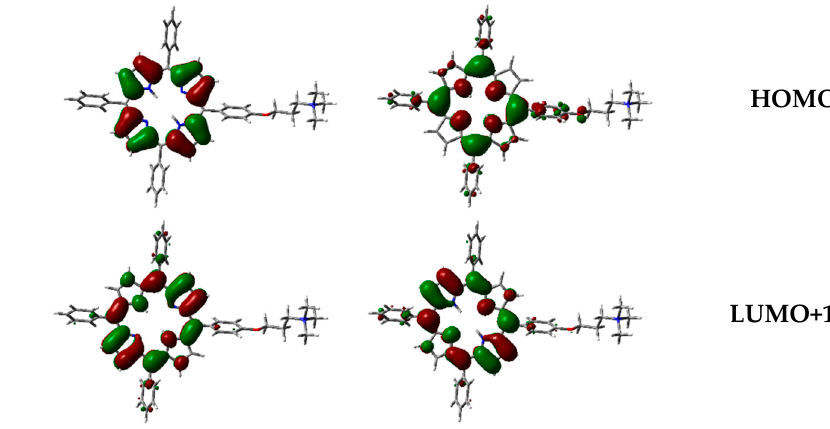
Figure 5. Frontier orbitals of 1H 2 calculated with B3LYP functional 6-31G(d) basis set.